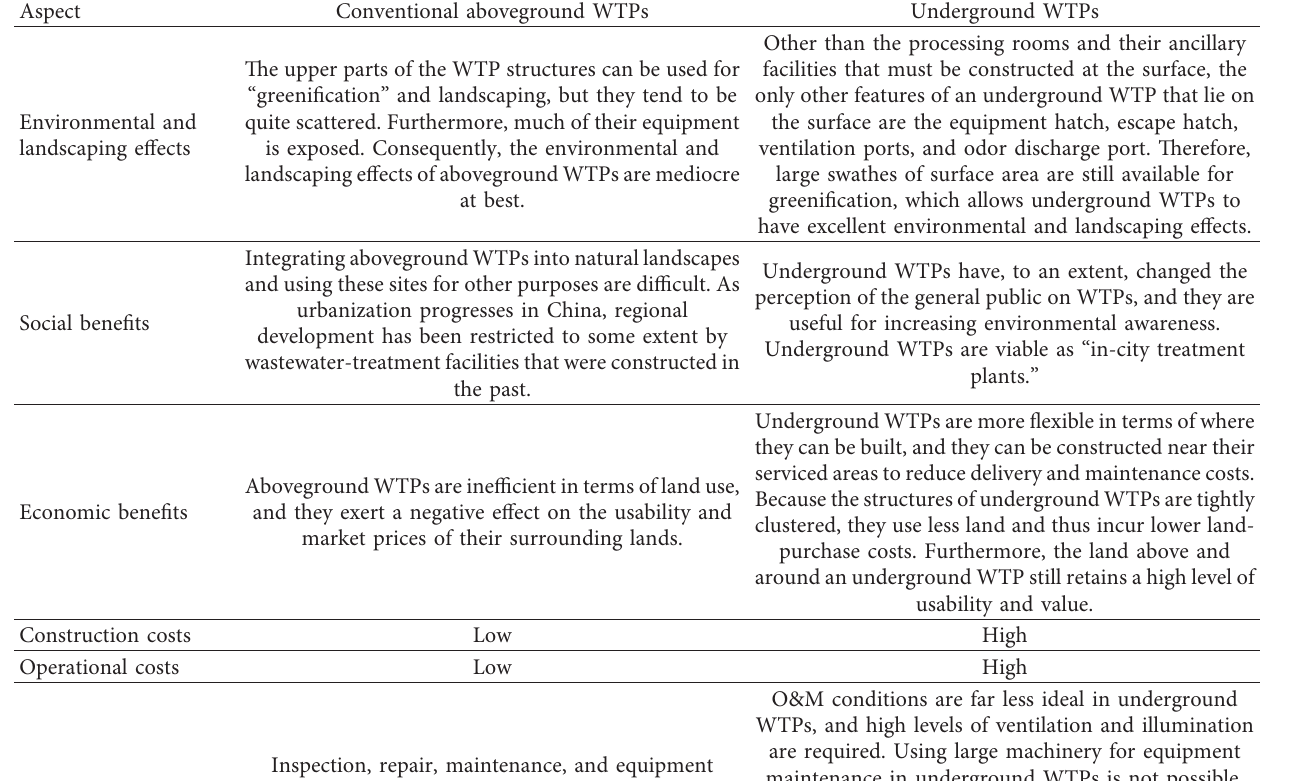
Table 2: Comparison between conventional aboveground and underground